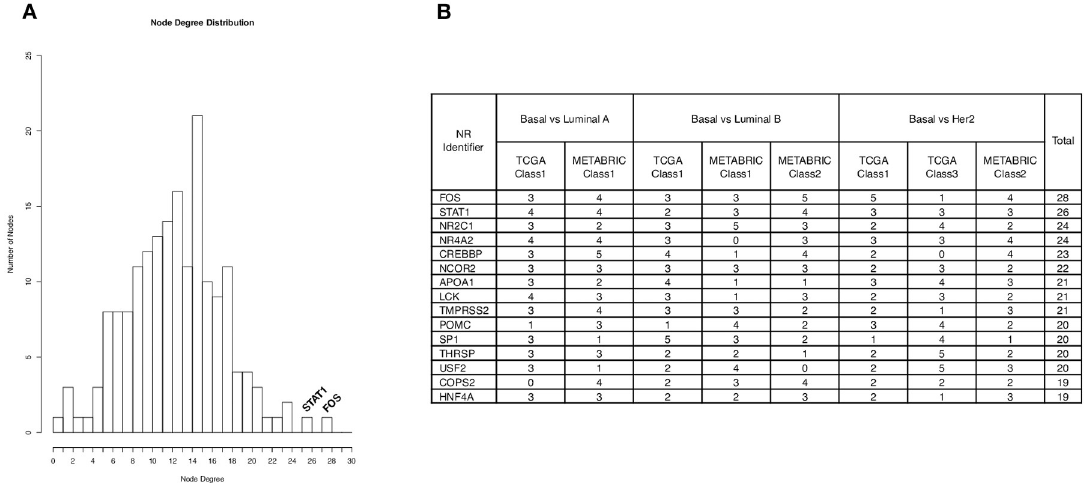
Fig 6. Node degree summary. A: The histogram shows the distribution of total degree of the nodes. FOS and STAT1 are the most connected nodes across networks with total degree of 28 and 26, respectively. They are defined as hubs and co-expression around the hubs was explored. B: The 15 most connected genes listed by the total number of connections in all Basal-specific networks. https://doi.org/10.1371/journal.pone.0252901.g006 three un-associated nodes seemingly independent. In this work, the correlations in the motifs represent paired associations between three nodes that are stronger than the 1.0% threshold to justify being included as edges. The 3-node motifs can have isomorphs for example NPU code 111 has six variants. NPU codes 021, 201 and 111 contain 3 nodes and 2 edges, representing 12